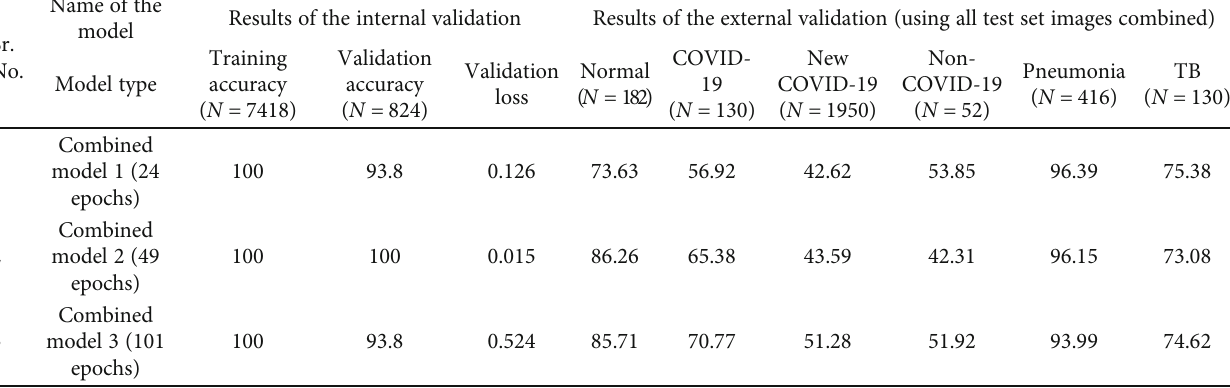
Table 4: Performance of combined models on training, internal validation, and external validation images. Sr.